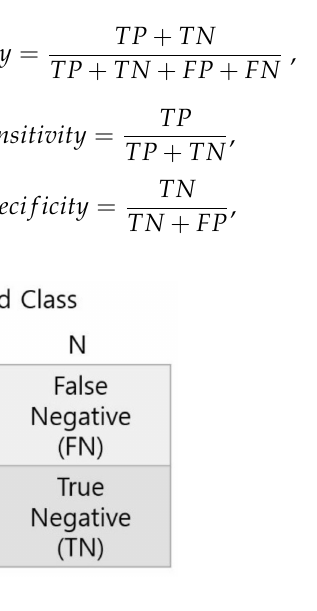
Figure 13. Confusion